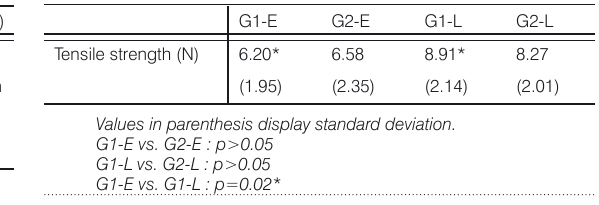
Table 2. The mean tensile strength values of the groups (N).